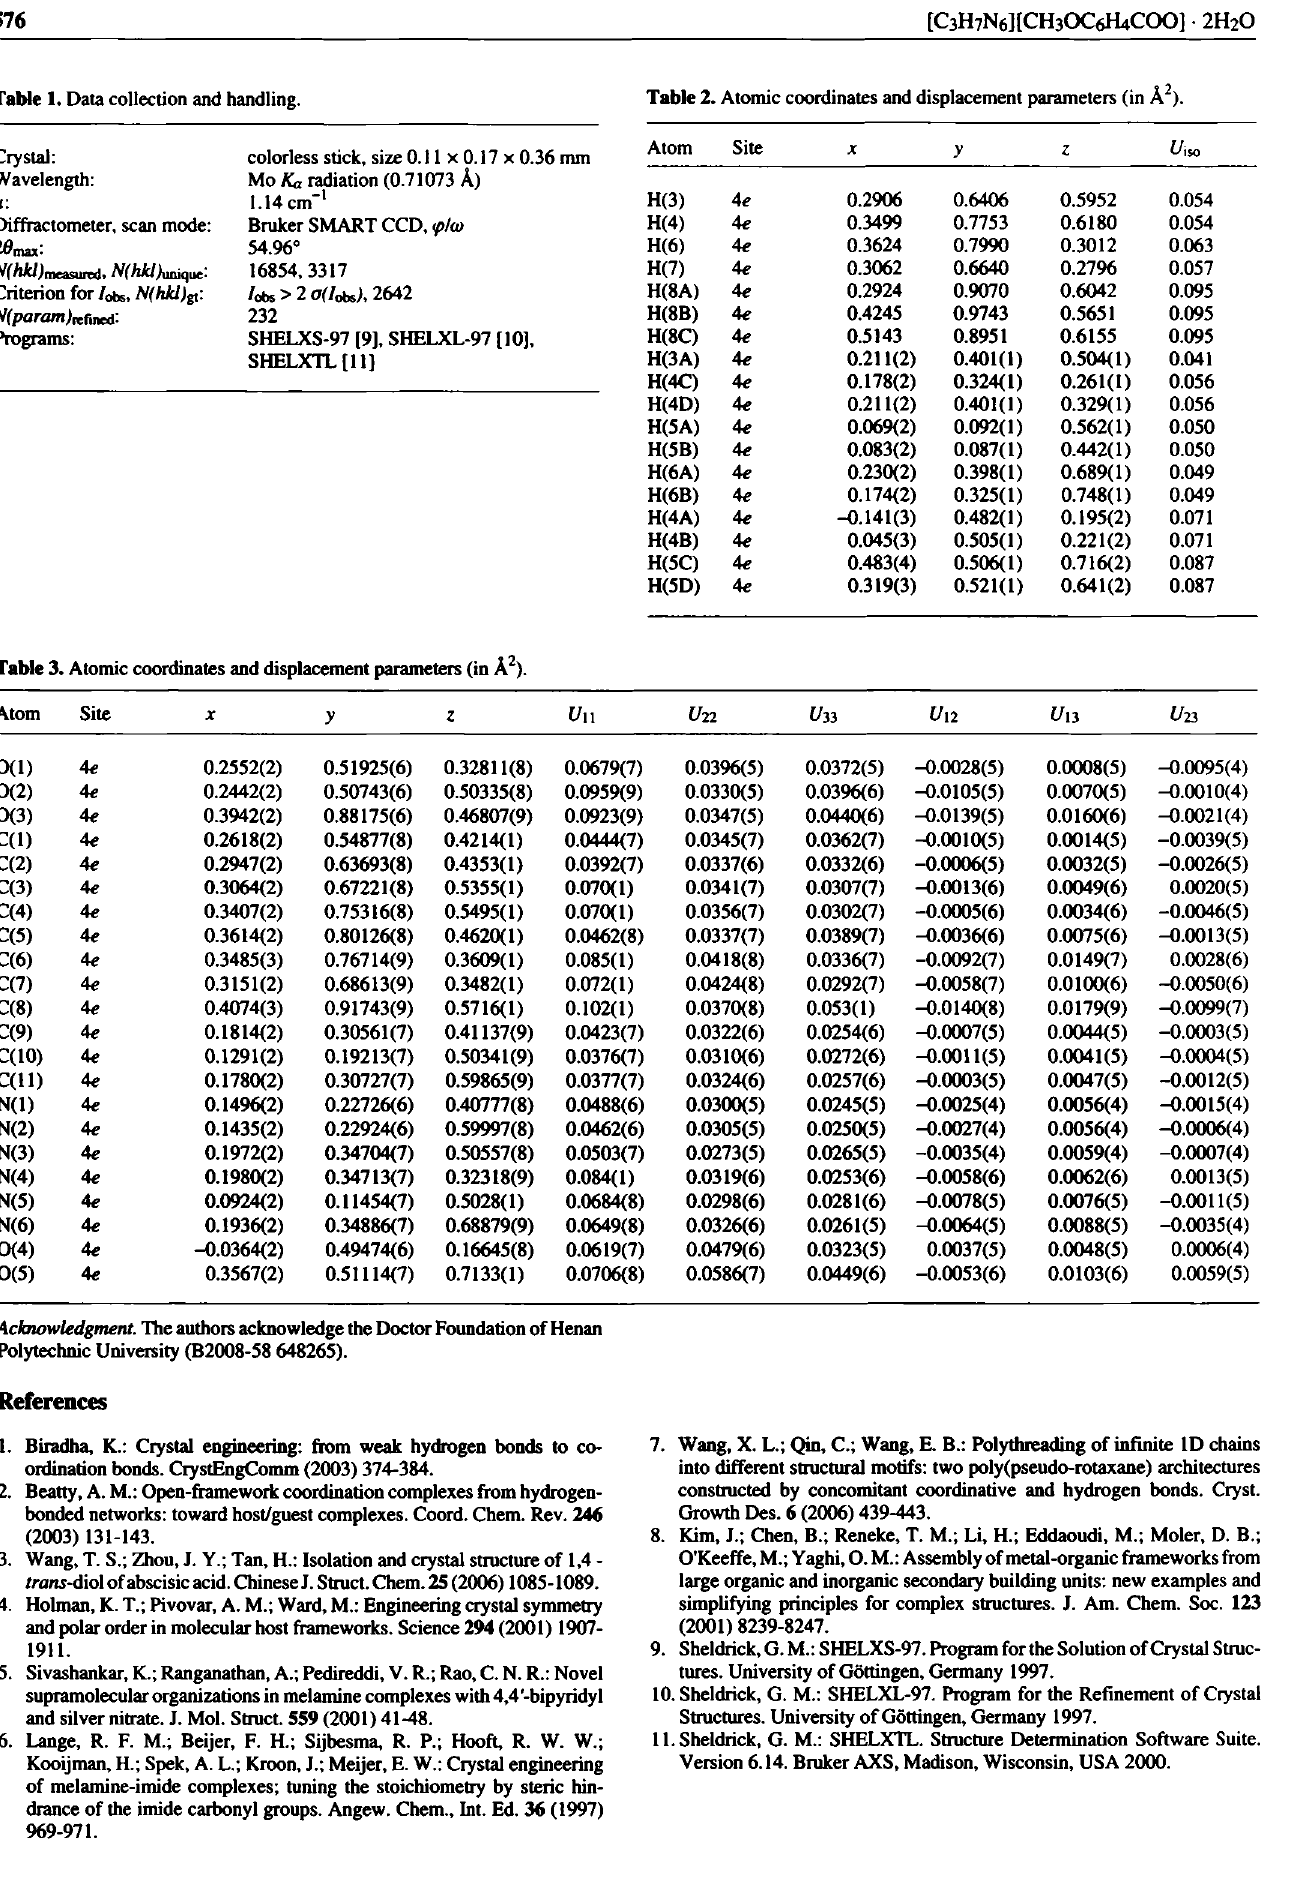
Table 1. Data collection and handling. Table 2. Atomic coordinates and displacement parameters (in Â 2 ).